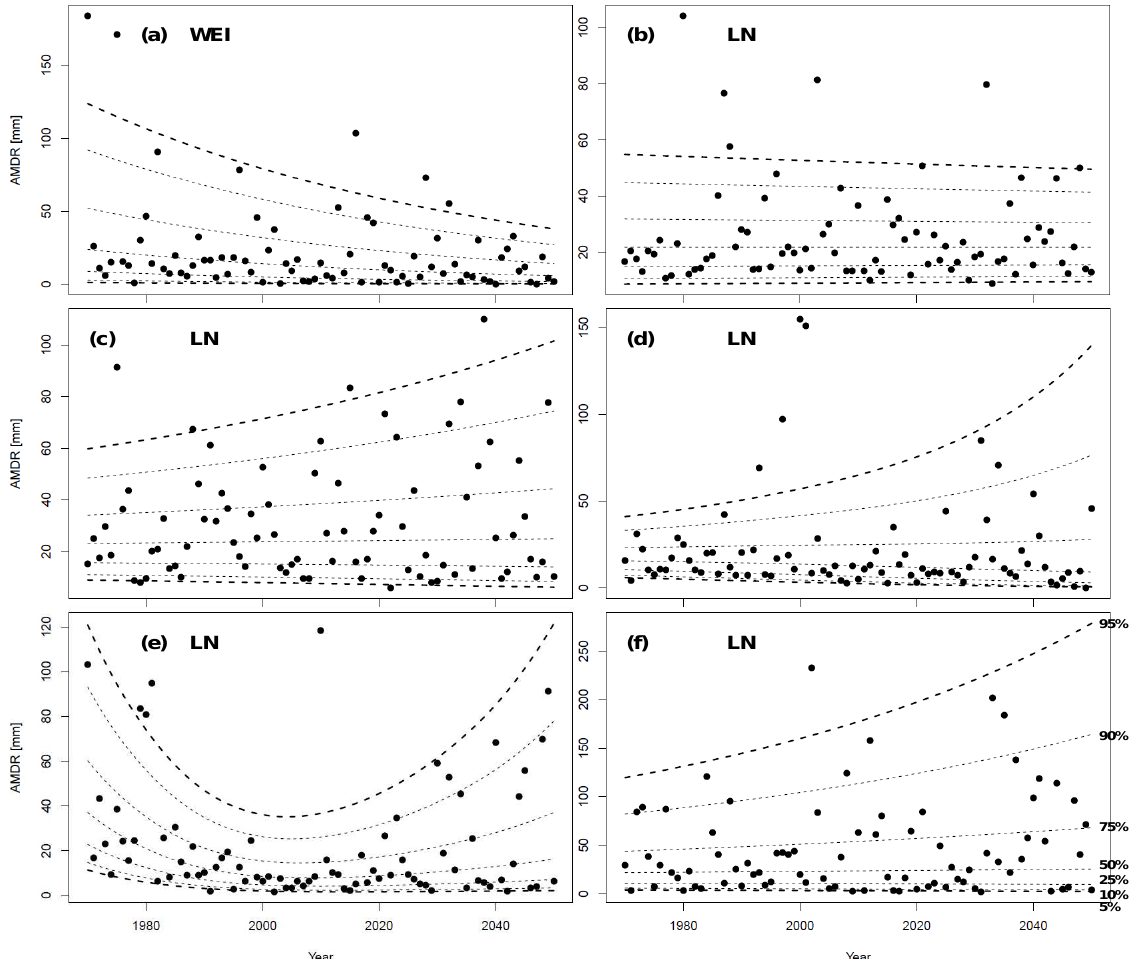
Fig. 3. GAMLSS analysis of AMDR (mm) for site 16 for several RCM: (a) GKSS/CLM, (b) METO-HC/HAD, (c) KNMI-RACMO, (d) INM-RCA, (e) SMHI/RCA, and (f) MPI-MREMO. The centile curves (5 to 95%) are represented by dashed lines. It should be noted that the ordinate scale is automatically